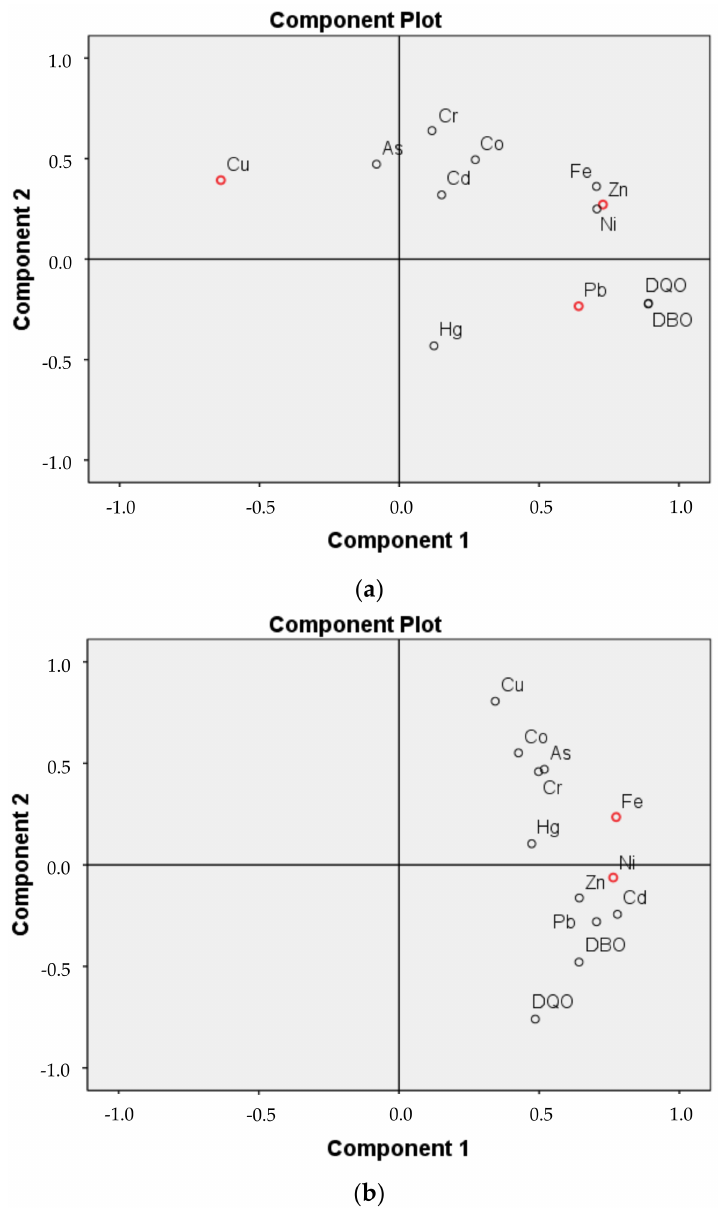
Figure 3. Principal component diagram for the concentrations of HMs, BOD 5 , and COD. ( a ) Untreated and ( b ) treated